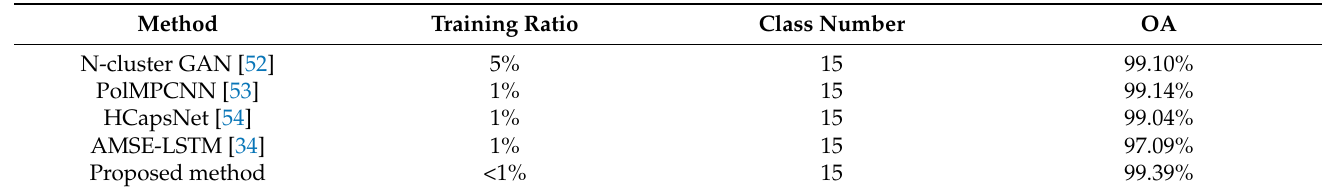
Table 6. Classification of state-of-the-art methods on the Flevoland-15 dataset.